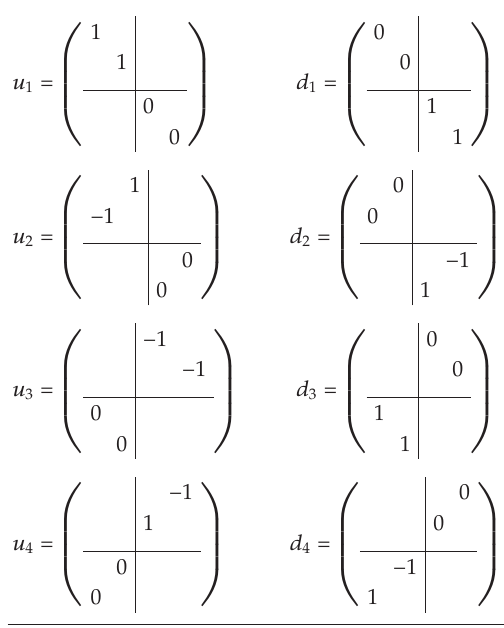
Table 3: Linkage matrices for the left 2-4-2 Adinkra shown in Figure 3. The linkage matrices for the right Adinkra in that figure are obtained from these by changing the sign of u 3 and d 3